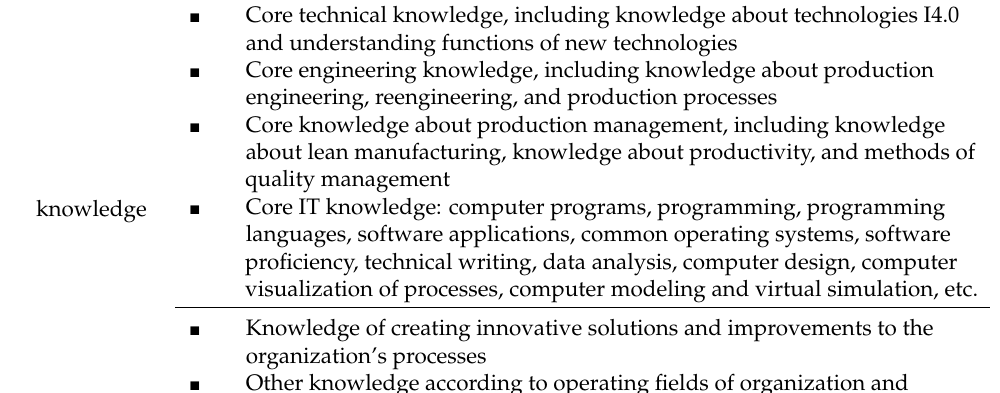
Table 2. Key skills and competencies in the O4.0 portfolio.